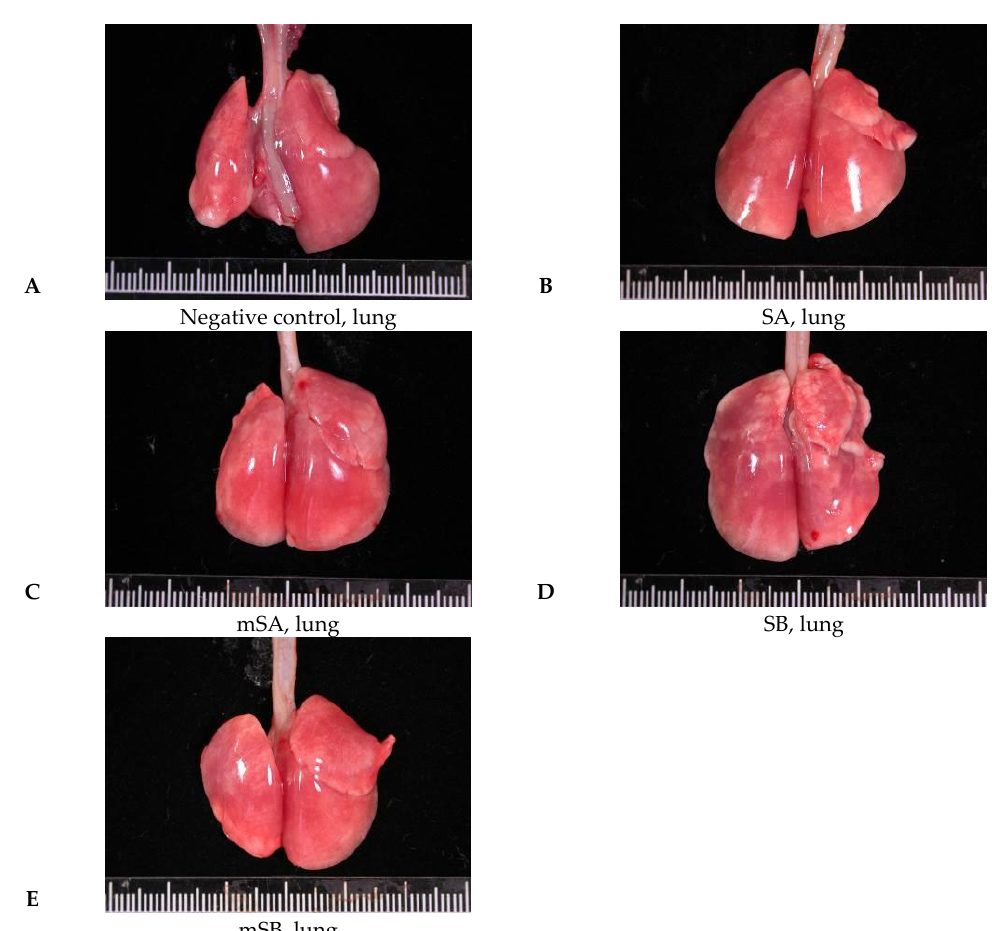
Figure 5. Gross findings of lungs of rats after intratracheal instillation with unmodified and modified nano-silica in the acute pulmonary toxicity on Day 14. Normal gross of lung of control group ( A ), SA group ( B ), mSA group ( C ), SB group ( D ), and mSB group ( E ) were found in rats. Negative control: R.D.W, 0.5 mL/kg bw, i.t.; SA: sample A, 0.645 mg/kg bw, 320× diluted, 0.5 mL/kg bw, i.t.; mSA: modified sample, 0.06 mg/kg bw, 320× diluted, 0.5 mL/kg bw, i.t.; SB: sample B, 2.24 mg/kg bw, 80× diluted, 0.5 mL/kg bw, i.t.; mSB: modified sample B, 0.24 mg/kg bw, 80× diluted, 0.5 mL/kg bw, i.t.